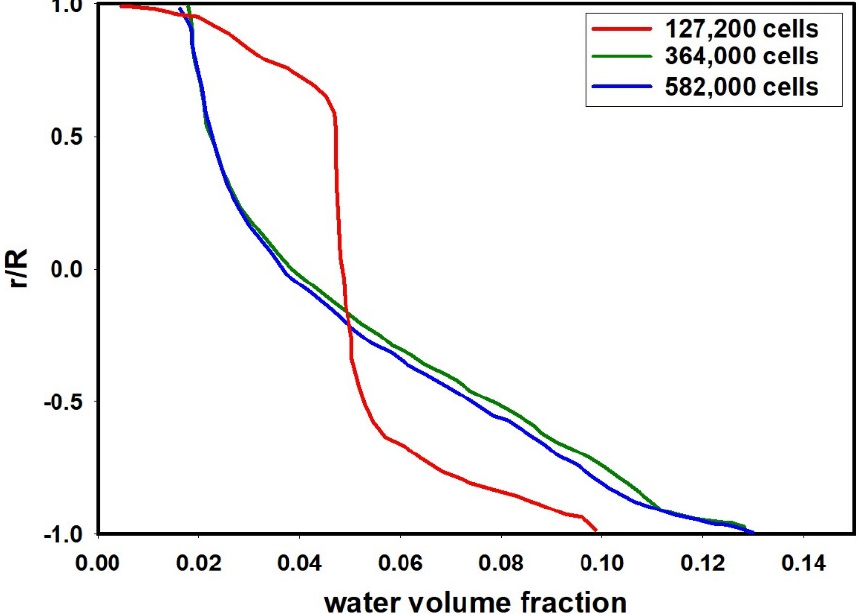
Figure 6. The influence of grid number on the CFD results regarding the distribution of water volume fraction (V = 1.25 m/s, water cut = 0.05).